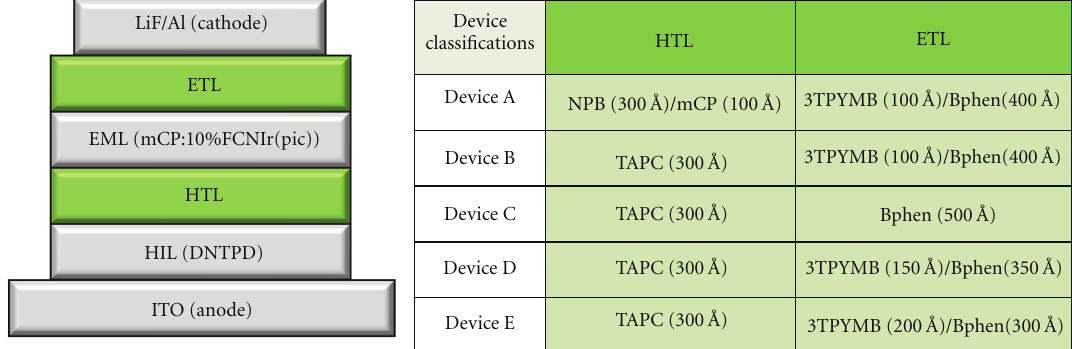
Figure 1: Basic structure and classification of the fabricated devices.